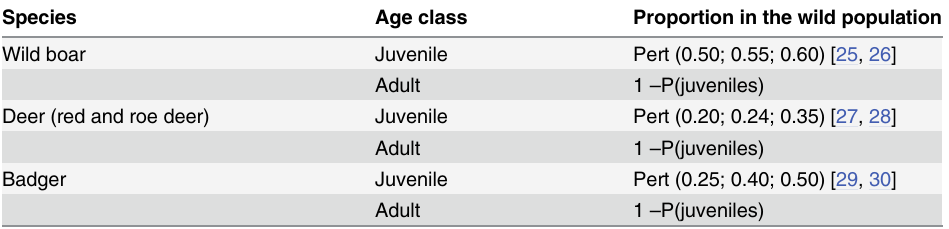
Table 1. Proportion of juveniles and adults in the wildlife population according to